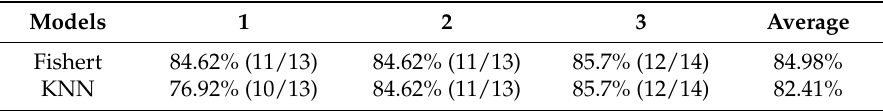
Table 2. Results of a three-fold cross validation test of two different